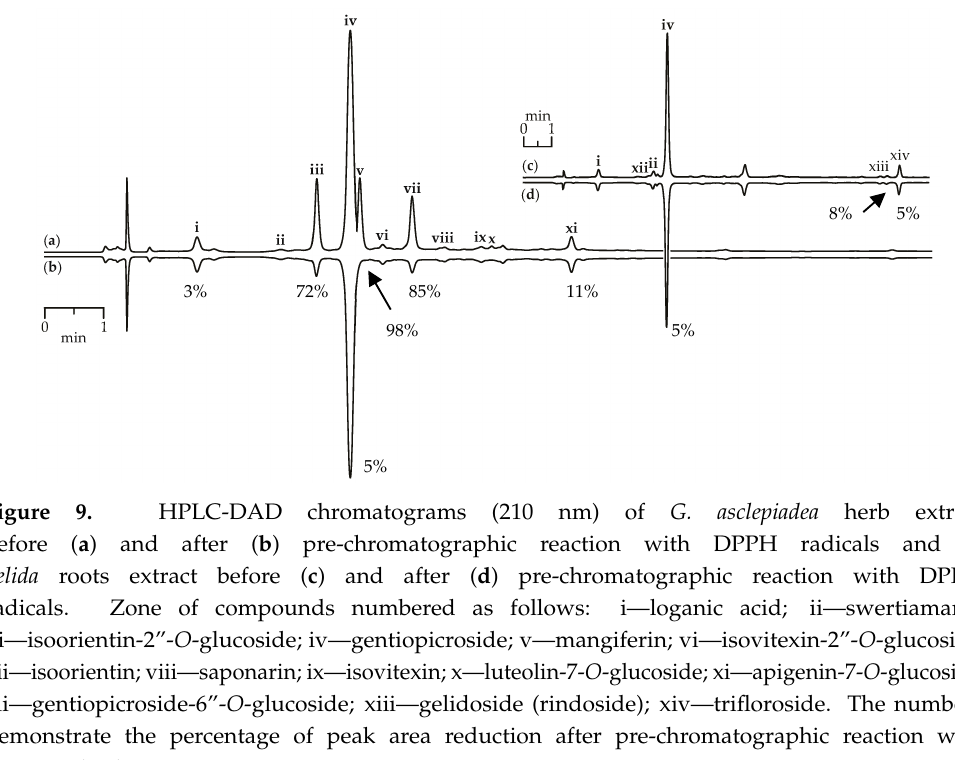
xiii—gelidoside (rindoside); xiv—trifloroside. The numbers demonstrate the percentage of peak area reduction after pre-chromatographic reaction with DPPH radicals.